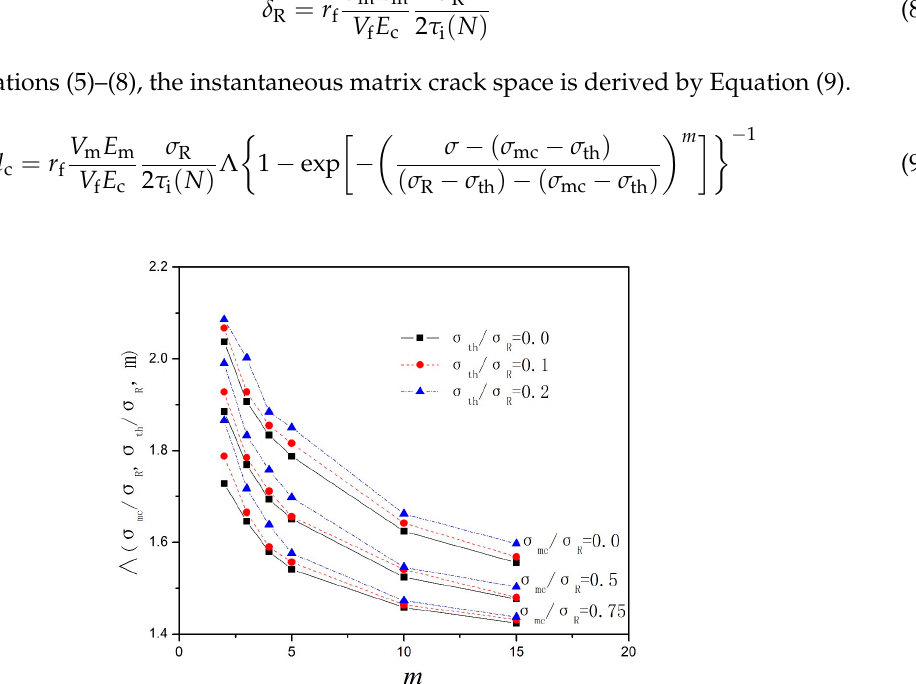
Figure 3. The final nominal matrix crack spacing versus the matrix Weibull modulus of various σ mc / σ R and σ th / σ R .